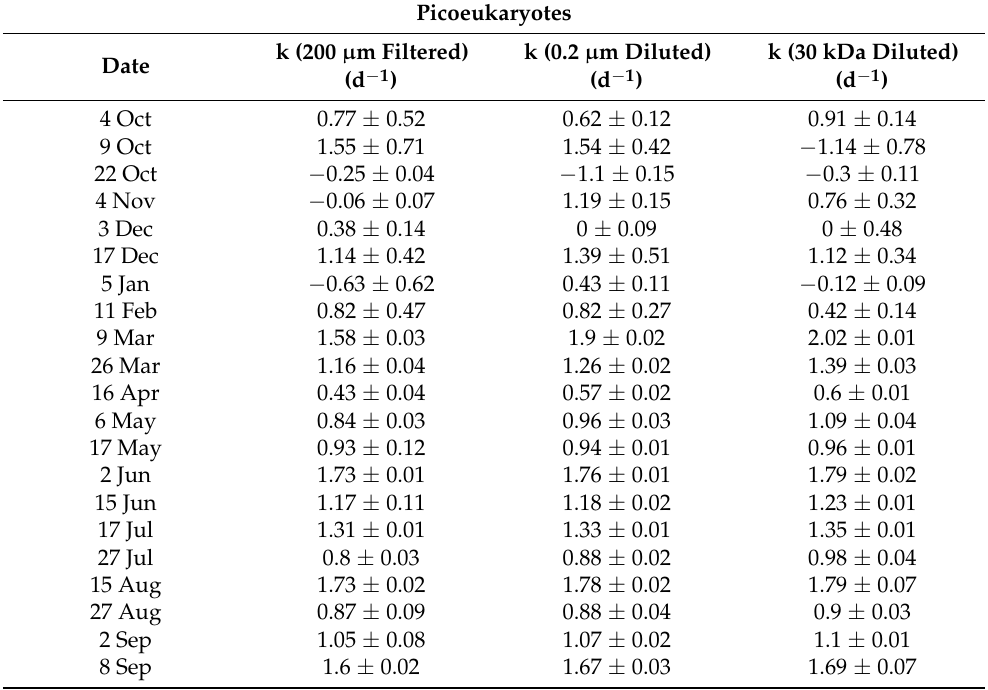
Table 2. Net growth rates of picoeukaryotes in each treatment incubation: 200 µ m filtered water